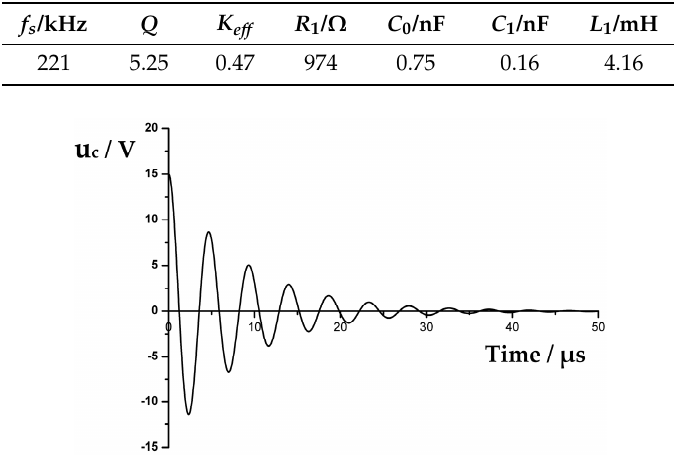
Figure 5. Residual vibration waveform of the transducer.